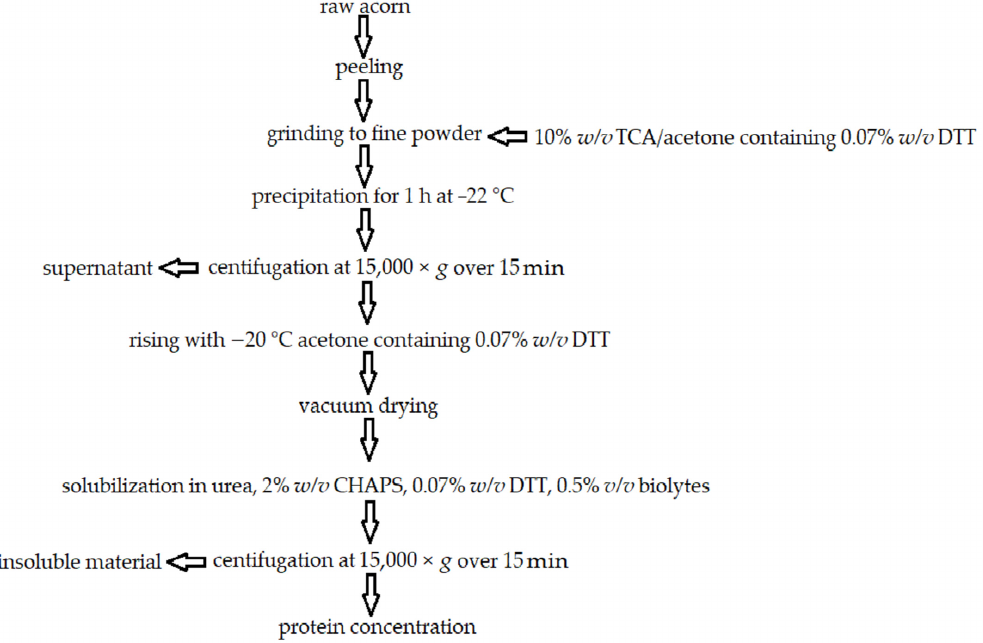
Figure 4. Flow chart of acorn protein extraction. Own figure based on Ref. [133]. 2022, Galván et al.